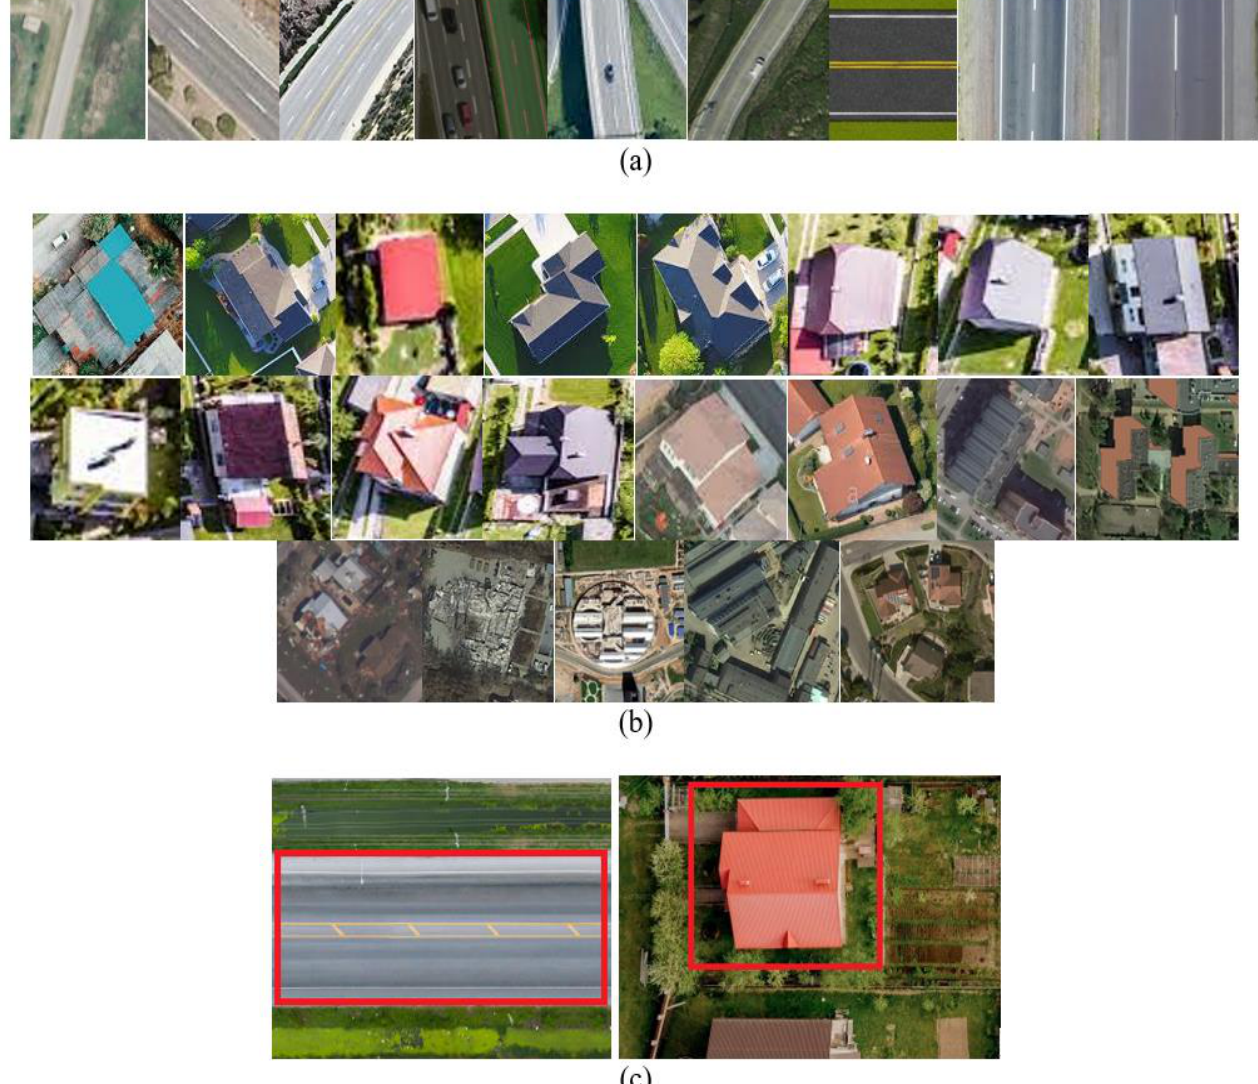
Figure 7. ( a ) Subset of aerial road images used for training ( b ) Subset of aerial building images used for training ( c ) Haar Cascade Classifier Results.